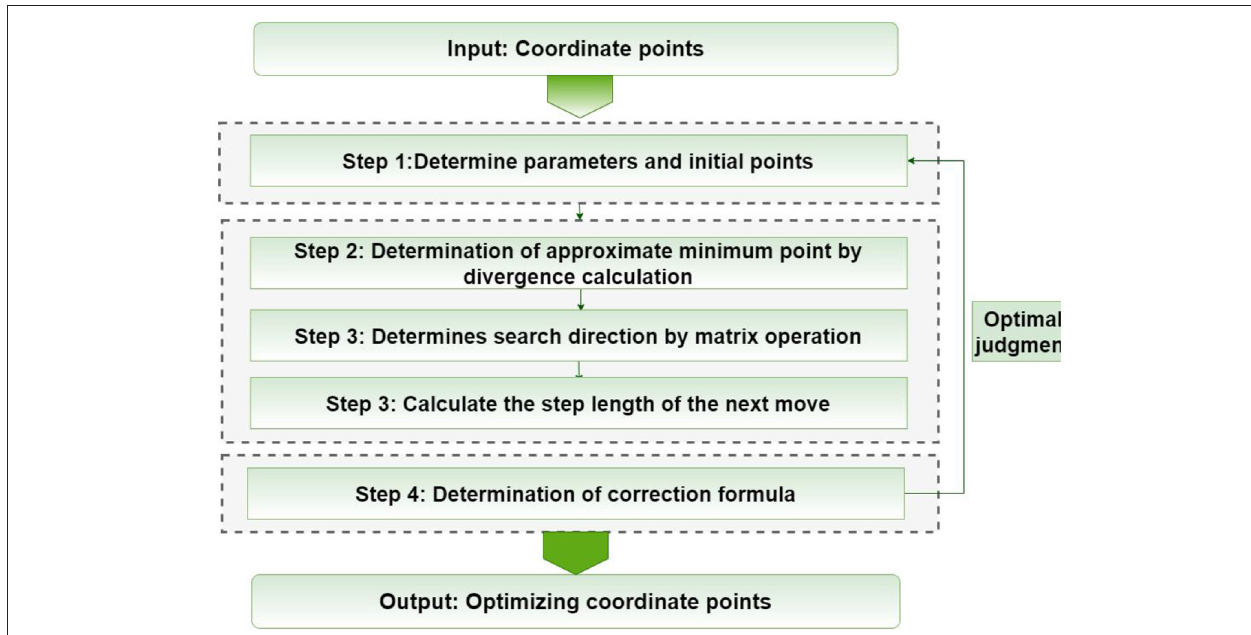
FIGURE 5 | Flow chart of DFP optimization algorithm.